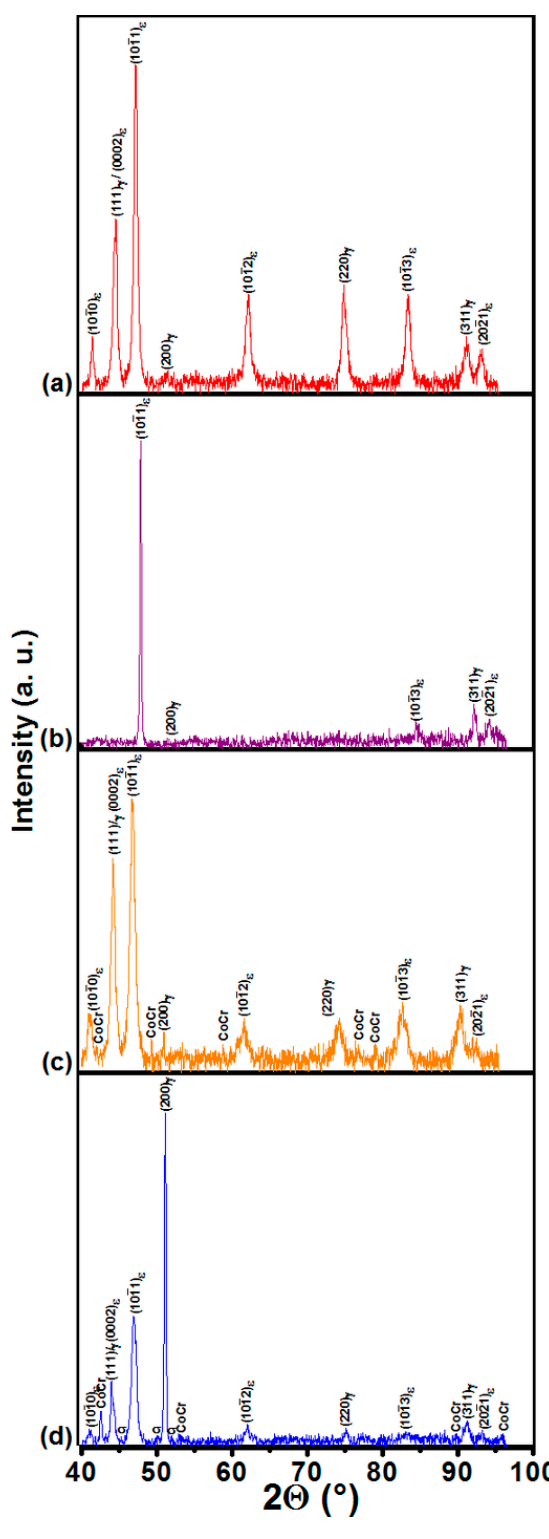
Figure 5. Representative X ‐ ray diffraction patterns for the Co ‐ Cr alloys: ( a ) Co ‐ 20 wt. % Cr, ( b ) Co ‐ 30 wt. % Cr, ( c ) Co ‐ 35 wt. % Cr, ( d ) Co ‐ 40 wt. % Cr at the center of the wedge ‐ shaped cooper mold.